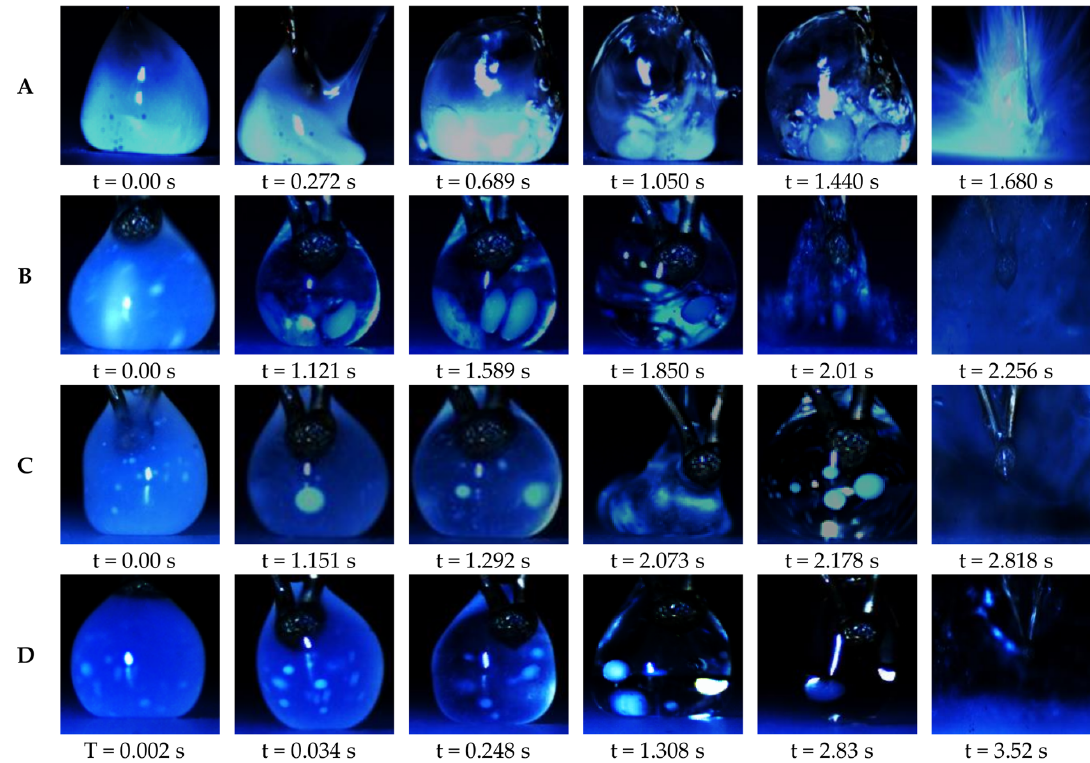
Figure 5. Micro-explosion behavior during Leidenfrost of cases A, B, C and D.